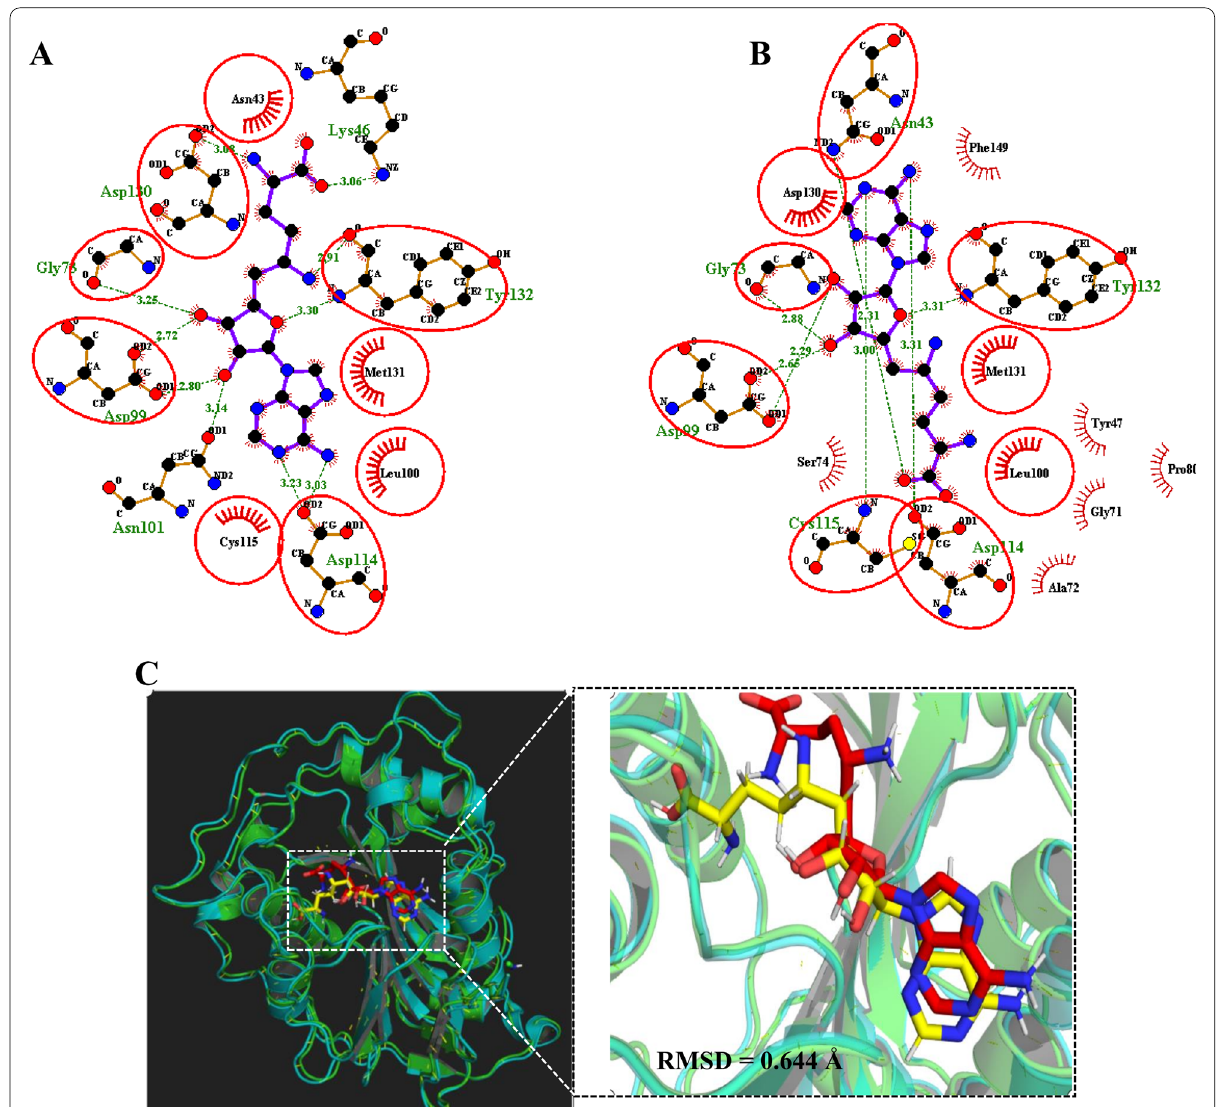
Fig. 2 2D molecular interaction analysis and superimposition of re-docked nsp16. A 2D molecular interaction of re-docked SGF with nsp16 active site. B The binding sites of SGF with nsp16 active site in co-crystalize complex. C Superimposition of the co-crystallized ligand (yellow) and the re-docked ligand (Red) (RMSD 0.644 =